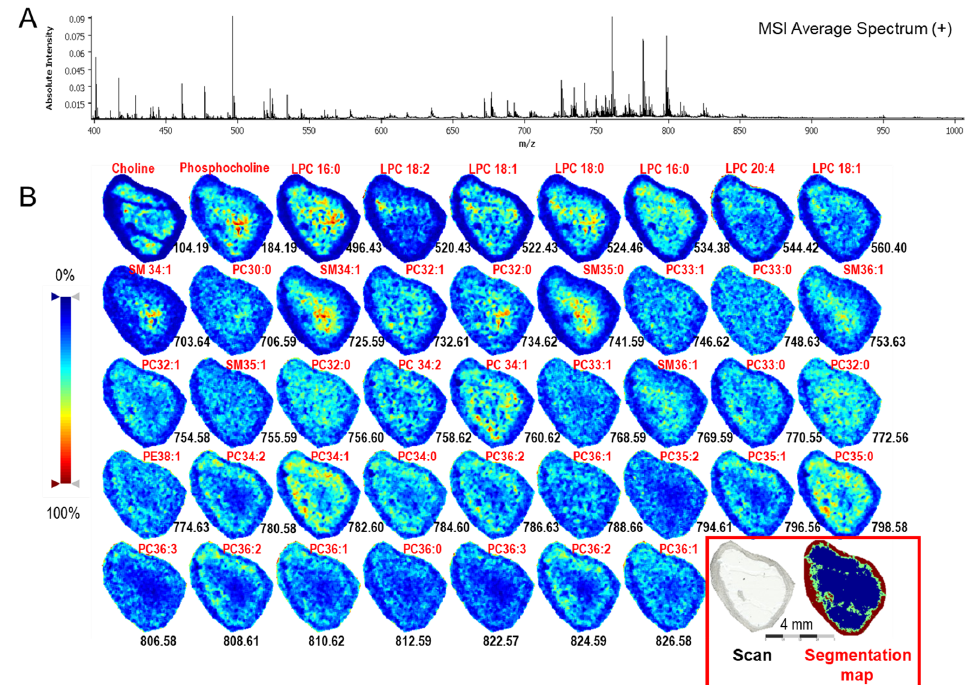
Figure 3. High-resolution mass spectrometry imaging (MSI) of individual bovine follicles. ( A